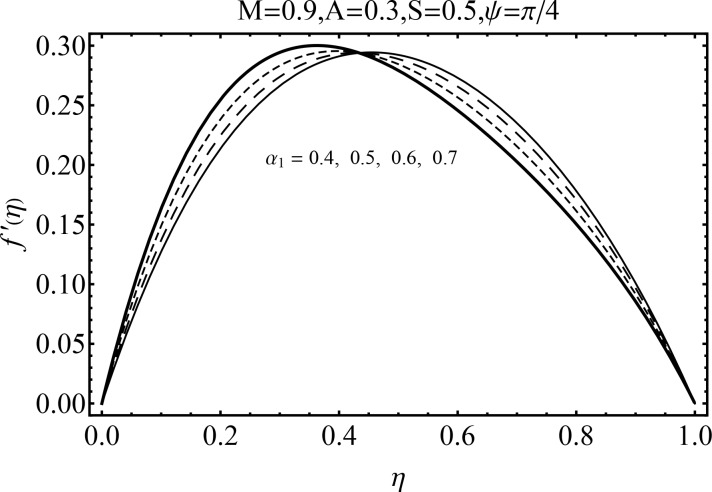
Influence of α1 on f′(η).